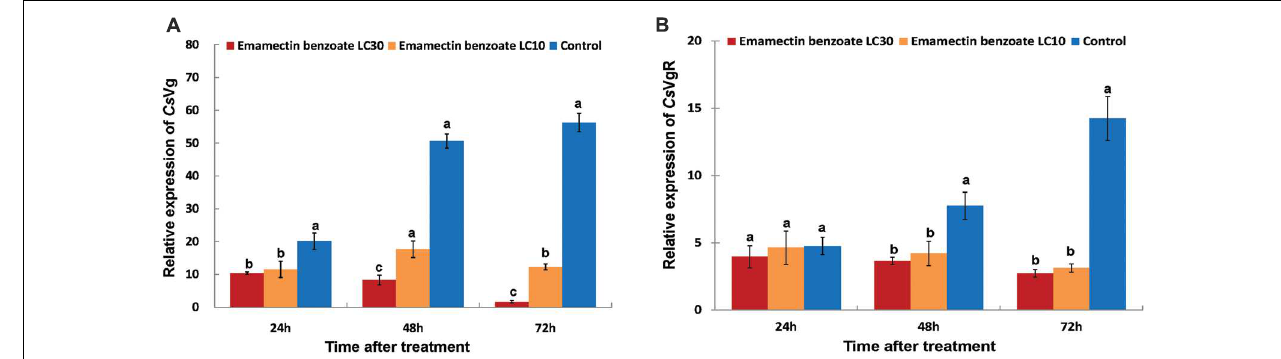
FIGURE 5 | Effects of emamectin benzoate exposure (EB) on the gene expression of CsVg and CsVgR in C. sinensis at the sublethal concentrations. The figure shows the gene expression of CsVg (A) and CsVgR (B) in C. sinensis at different treatments (LC 10 EB, LC 30 EB, and Control). The bars represent the average ( ± SD) of the relative CsVg and CsVgR expression with β -actin as the housekeeping gene. Different lowercase letters above the columns indicate significant differences (Tukey’s test, P < 0.05).